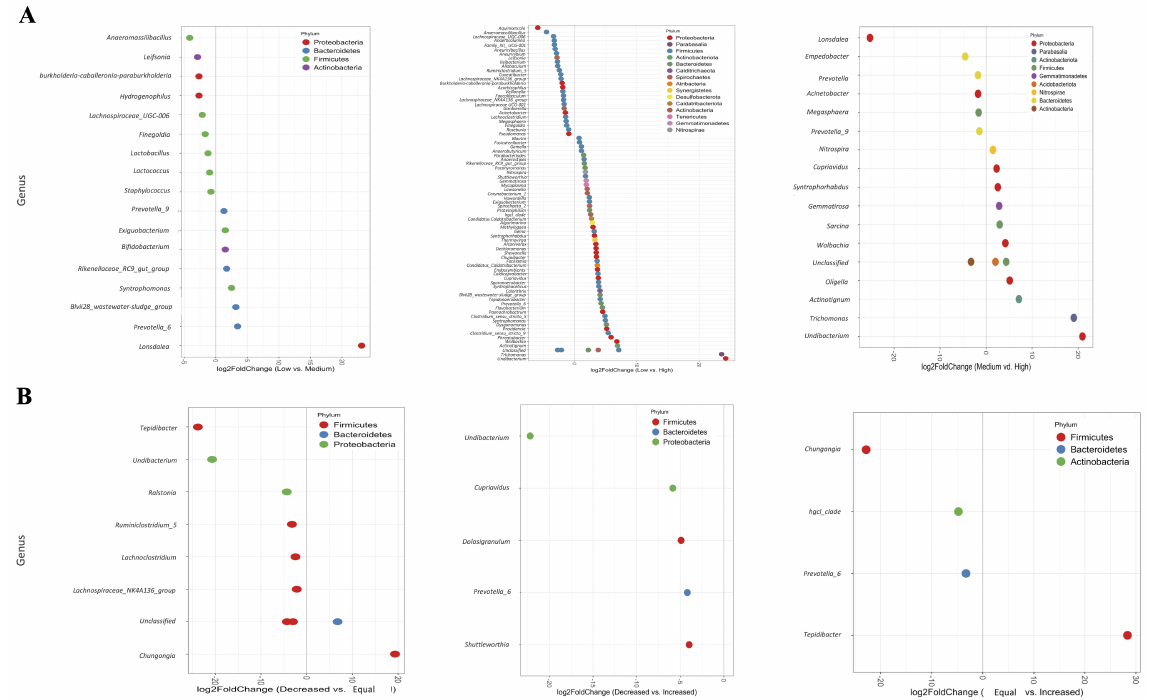
Figure 3. DESeq2 analysis for the identification of differentially abundant genera between groups according to viral load and viral load outcome. ( A ) Differentially abundant genera regarding viral load. Left and middle graphs consider the women with a low viral load as the point of comparison. The genera on the left side of the line are those with a decreased abundance in the women with low VL compared to those with medium or high VL. Conversely, the genera at the right side of the line are those with an increased abundance in the women with low VL. The right graph considers the women with a medium viral load as the point of comparison, where the genera on the left side of the line are those with a decreased abundance in the women with medium VL compared to those with low or high VL. Conversely, the genera at the right side of the line are those with an increased abundance in the women with medium VL. ( B ) Differentially abundant genera regarding viral load outcome. Left and middle graphs consider the women with a decreased viral load as the point of comparison, where the genera on the left side of the line are those with a decreased abundance in the women with a decreased VL, compared to those with an equal or increased VL. Alternatively, the genera at the right side of the line are those with an increased abundance in the women with a decreased VL. The right graph considers the women with equal VL as the point of comparison; thus, the genera on the left side of the line are those with a decreased abundance in the women with equal VL compared to those with an increased VL. Meanwhile, the genera at the right side of the line are those with an increased abundance in the women with equal